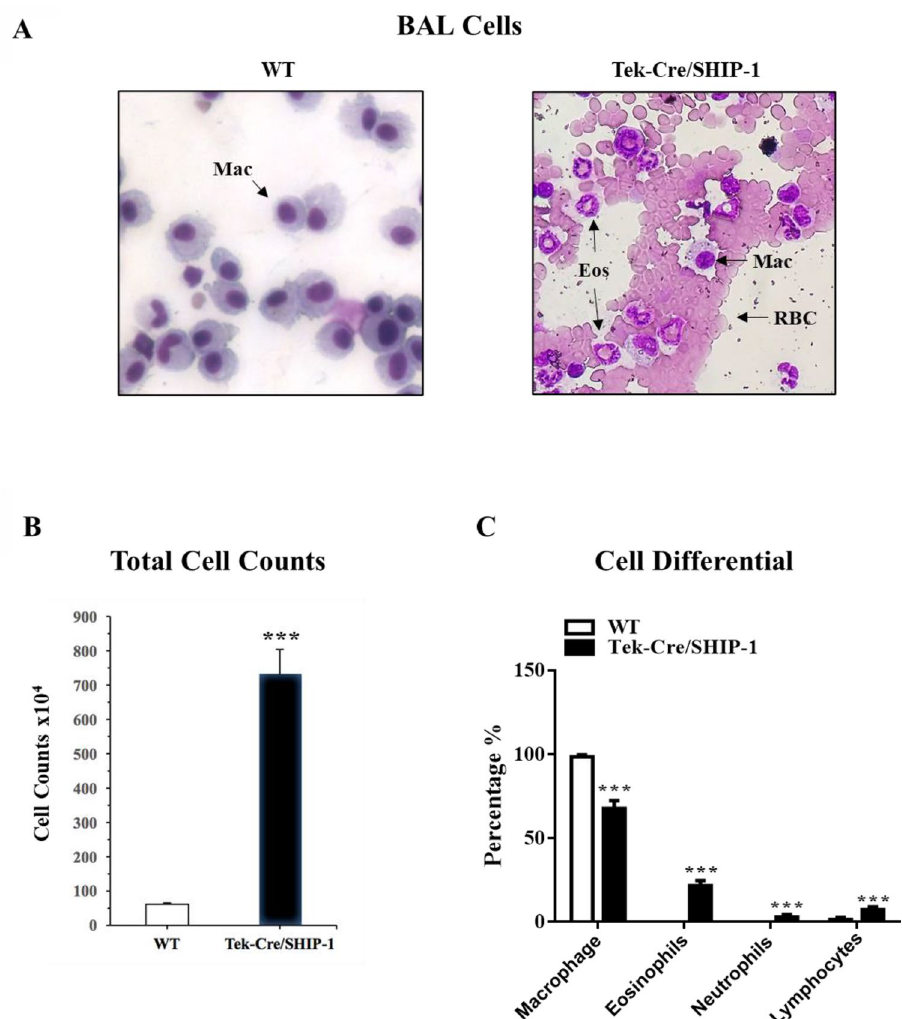
Figure 2. Analysis of bronchoalveolar lavage (BAL) cells. ( A ) Diff-Quik stained BAL cells (WT and Tek-Cre/ SHIP-1 mice). ( B ) BAL total cell counts and ( C ) Cell differential were obtained from WT mice and Tek-Cre/ SHIP-1 mice. Labels: Mac alveolar macrophages; Eos eosinophils; RBC red blood cells. Open bar: WT mice; Filled bar: Tek-Cre/SHIP-1 mice. (n = 5–6 mice for each group, ***P < 0.001 vs WT